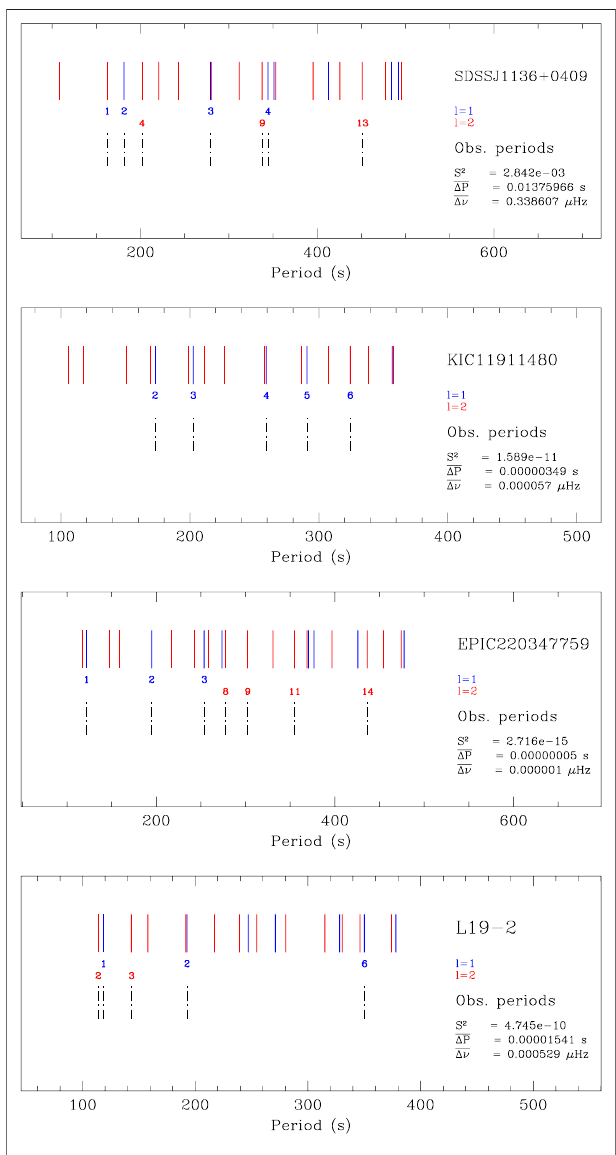
FIGURE 4 | Periods of the ℓ = 1 and ℓ = 2 g -modes from the optimal seismic models superimposed with the fi tted observed periods for the 4 ZZ Ceti stars analysed: SDSS J1136 + 0409, KIC 11911480, EPIC 220347759 and L19-2 (from top to bottom). Colors and numbers provide the corresponding mode identi fi cation (degree and radial order, respectively). Values obtained for the merit function, as well as the mean period and frequency dispersion of the fi t are also given as indicators of the achieved quality of fi t.